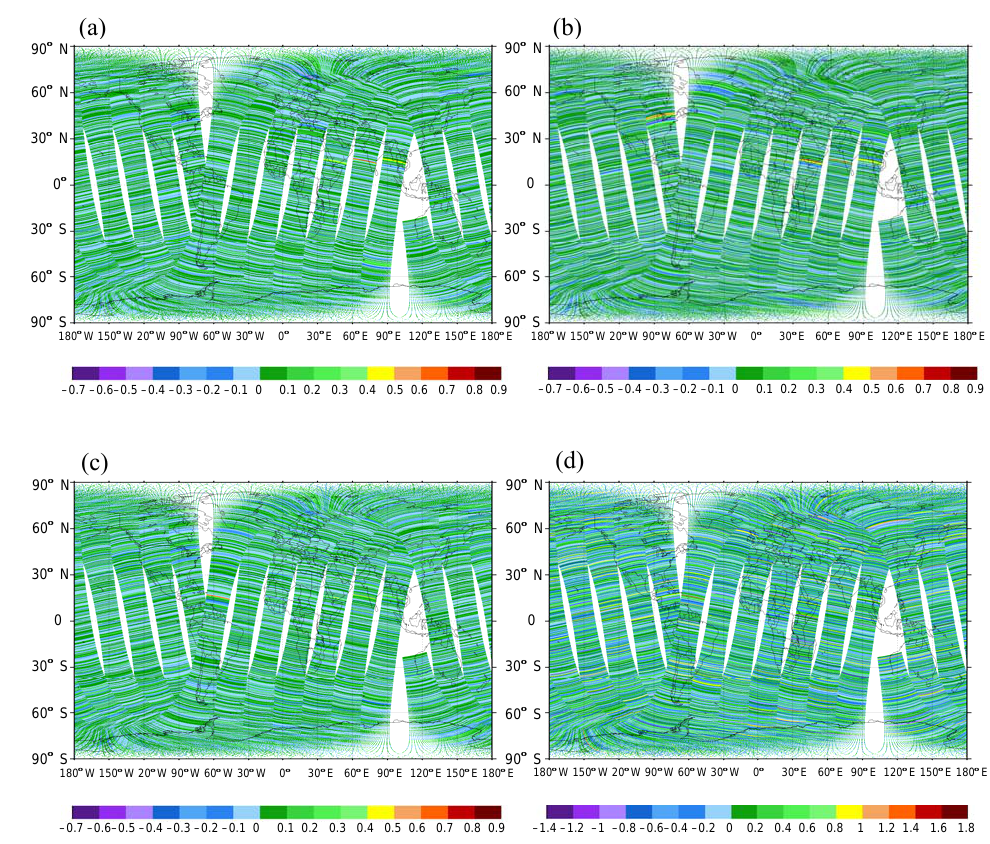
Figure 4. Global distribution of striping noise from FY-3C MWTS-2 (a) channel 5, (b) channel 6, (c) channel 7, and (d) channel 8 during 03:00–15:00UTC 1 July